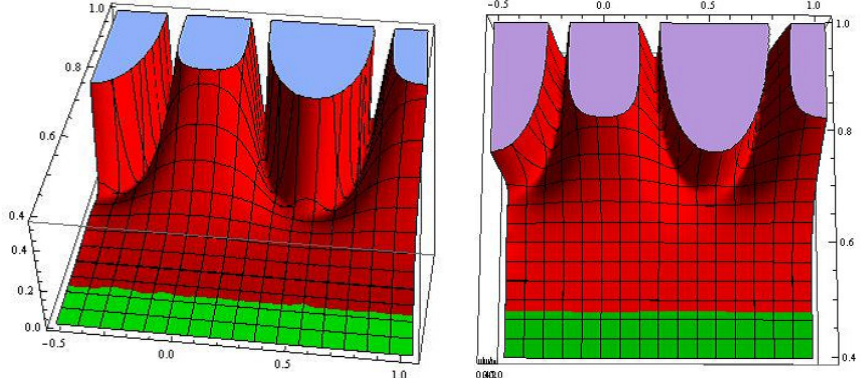
det W (the red domain) and the plane x 3 = 0 (the green domain) in −